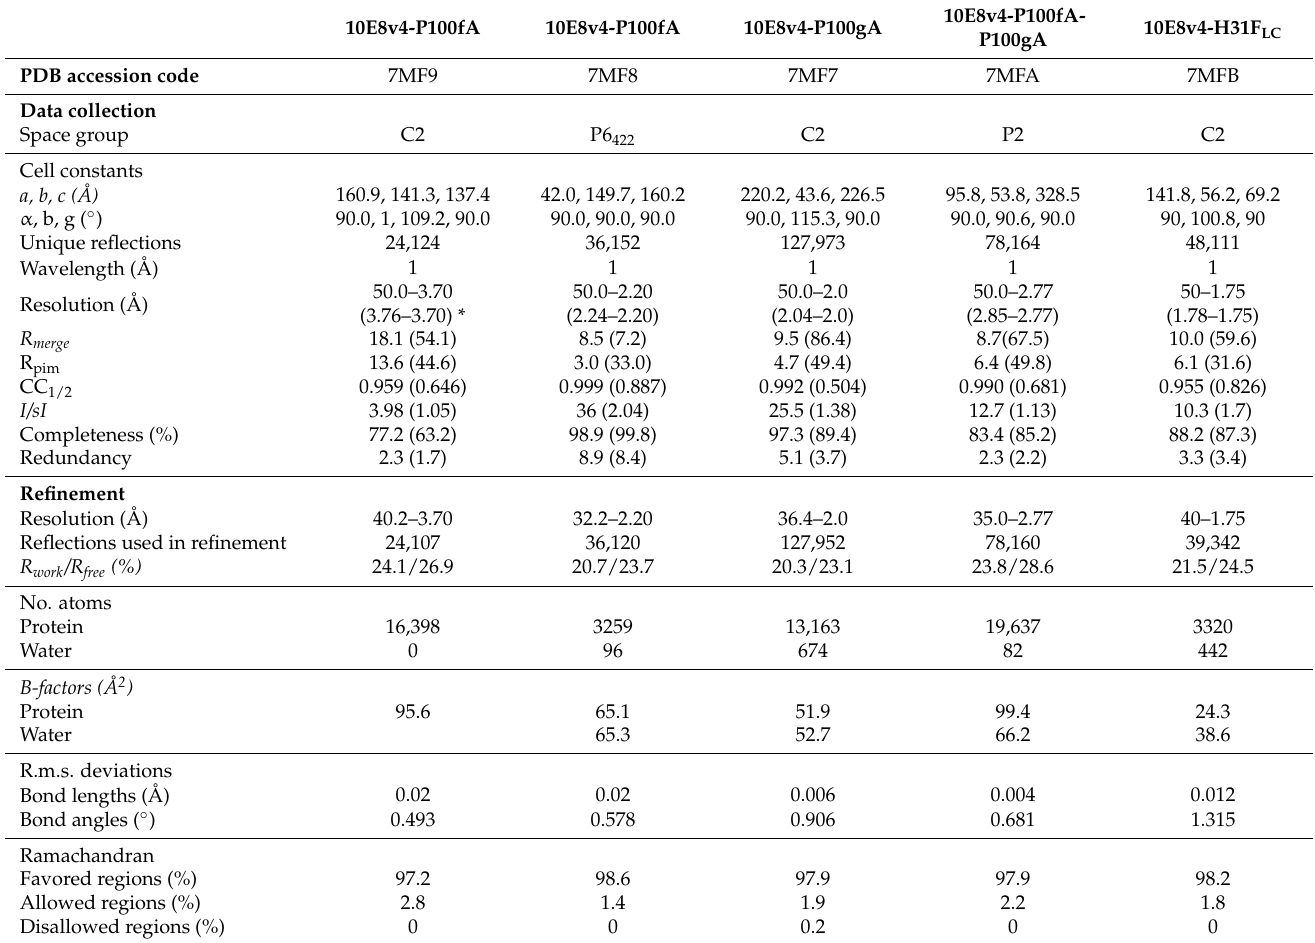
Table 1. Data collection and refinement